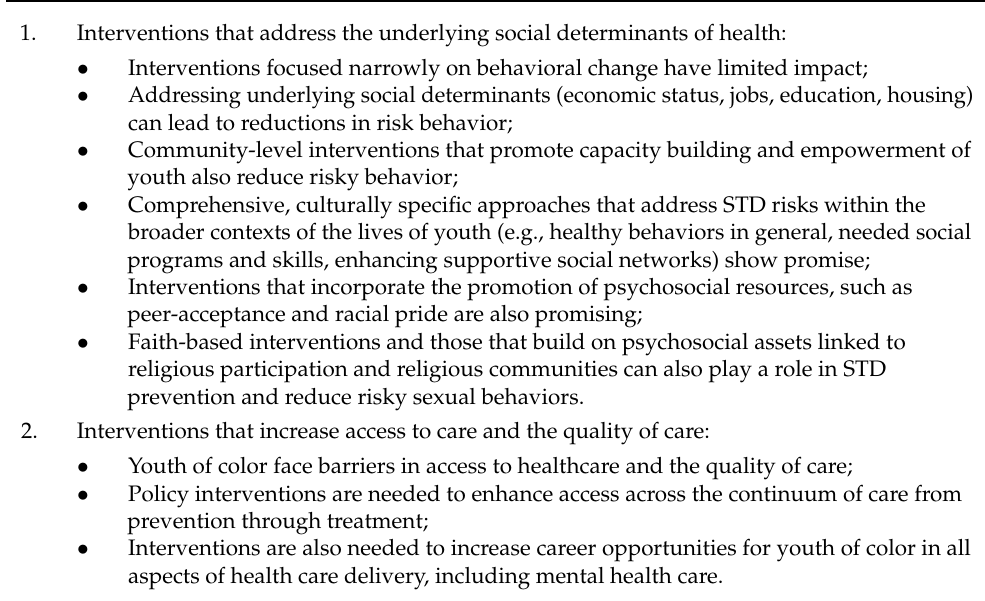
Table 3. Summary of opportunities for developing interventions built on the resources and strengths of